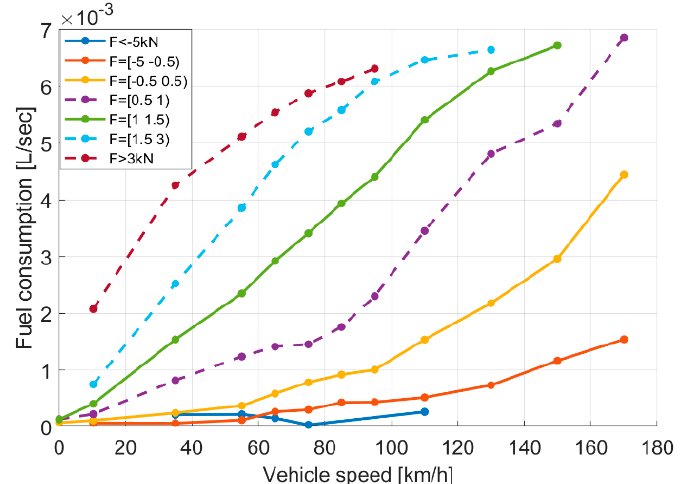
Figure 6. Traction Force-Speed Based Fuel Consumption Model.